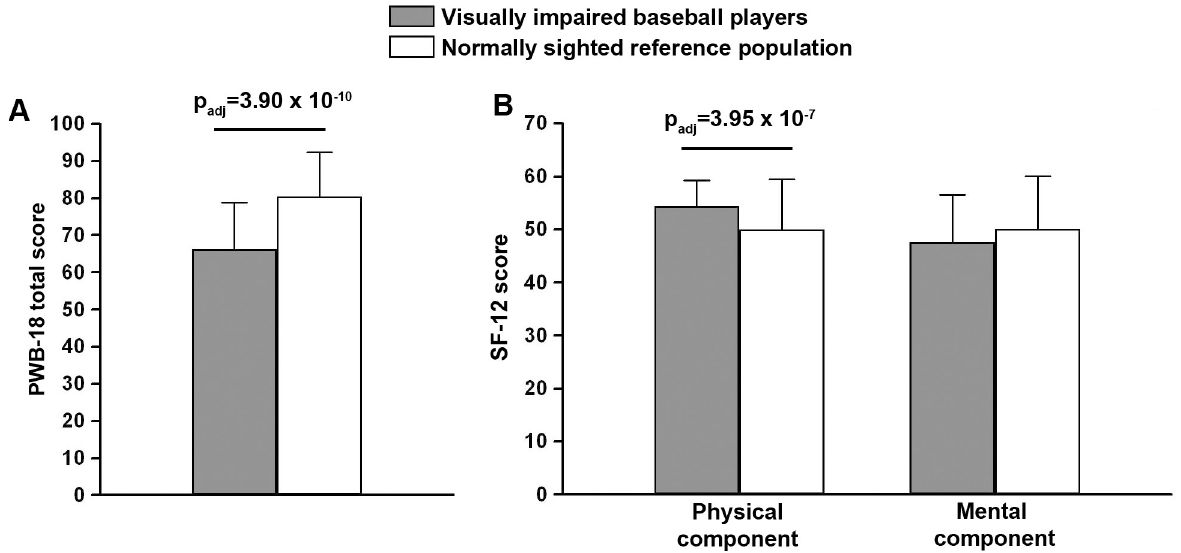
Fig 2. Comparison of PWB-18 total score ( A ) and SF-12 physical and mental component score ( B ) data from visually impaired baseball players and the Italian normally sighted reference population. Data are mean ± SD. Student’s t -test for unpaired data with post-hoc Bonferroni’s correction for multiple comparisons was used for statistical analysis; p adj , adjusted